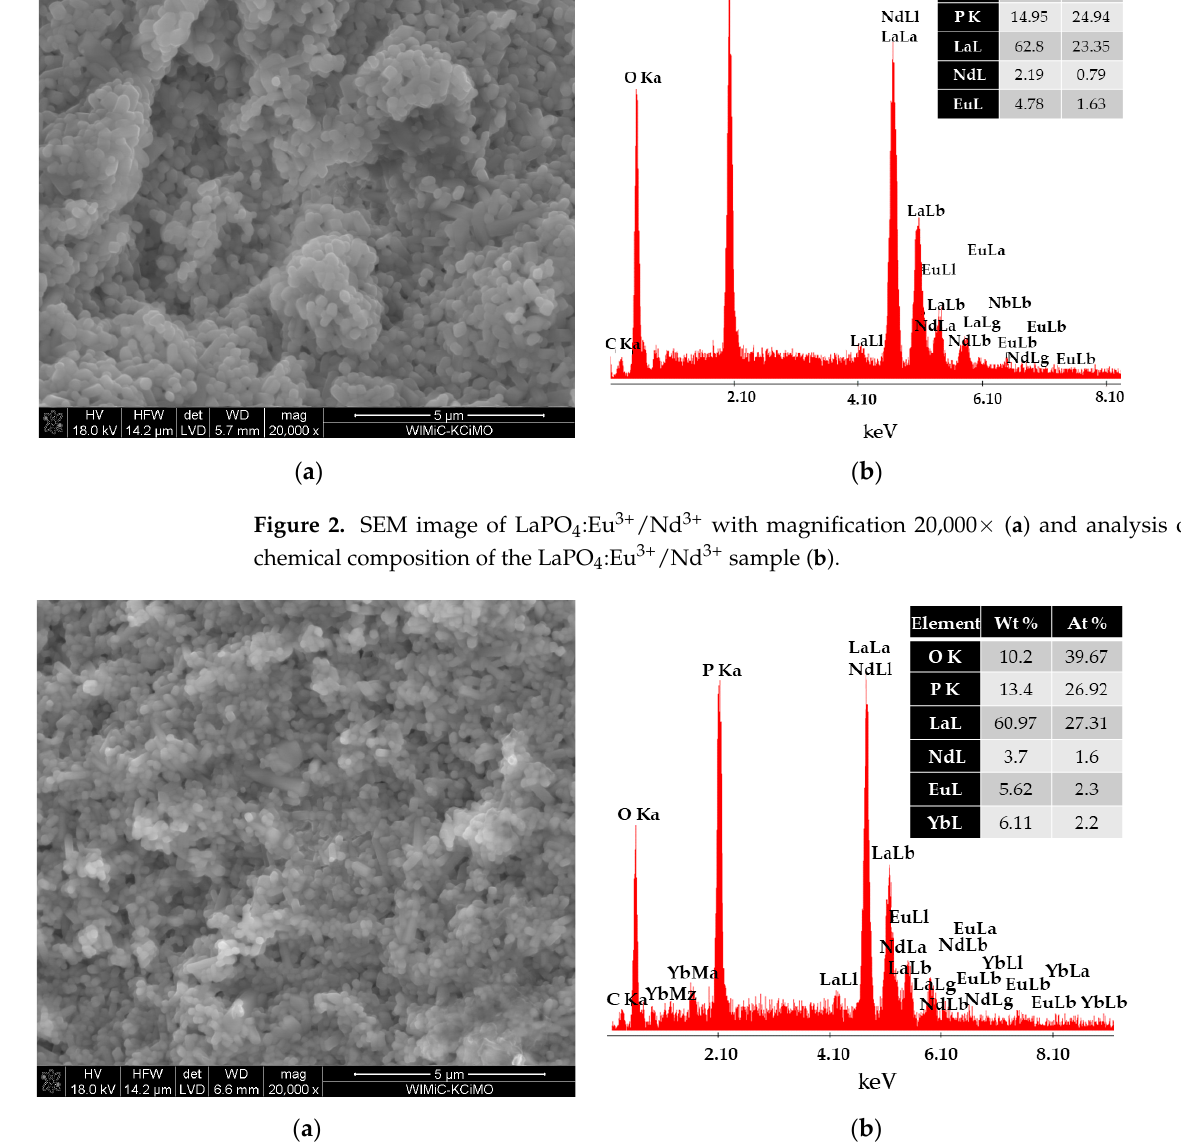
Figure 3. SEM image of LaPO 4 :Eu 3+ /Nd 3+ /Yb 3+ with magnification 20,000× ( a ) and analysis of the chemical composition of the LaPO 4 :Eu 3+ /Nd 3+ /Yb 3+ sample ( b